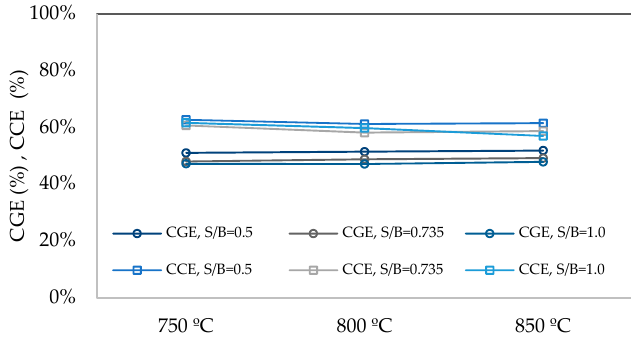
Figure 10. Effect of the temperature and S/B ratio on CCE and CGE.